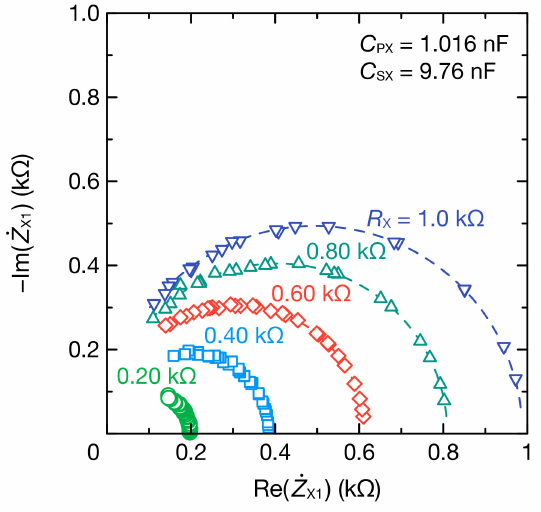
. Z X1 for the parallel RC circuits with C PX = 1.016 nF and C SX = 9.76 nF. Figure 10. Cole–Cole plot of The dashed lines represent the fitting curves obtained from Equations (9) and (10).